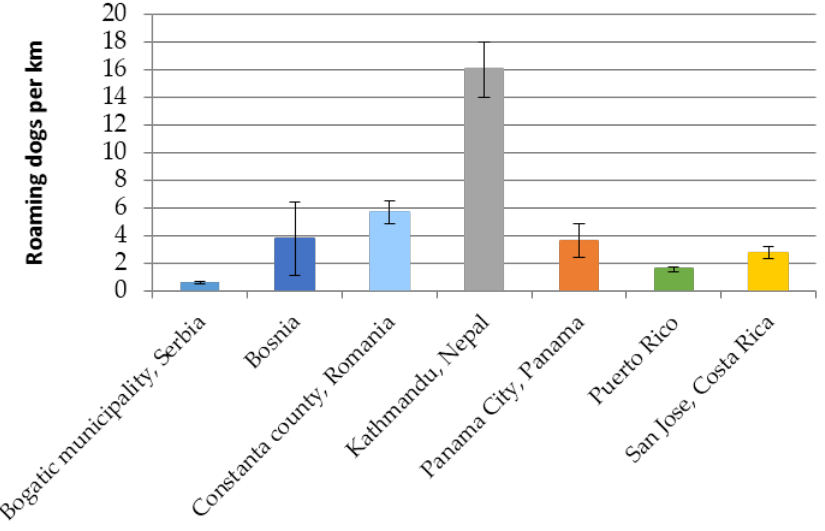
Figure 3. Bar chart showing the difference in average roaming dog density per km along both hotspot and representative routes in seven locations (it should be noted that both the design of the routes and the degree of urbanization along these routes varies between location, hence the average density along routes cannot be taken to represent national or regional roaming dog density), error bars shown are +/− one standard error.